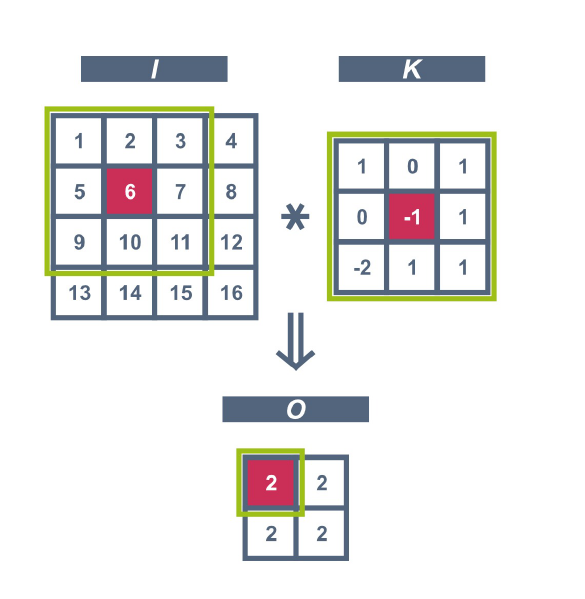
Figure 2. A 2D convolution example.